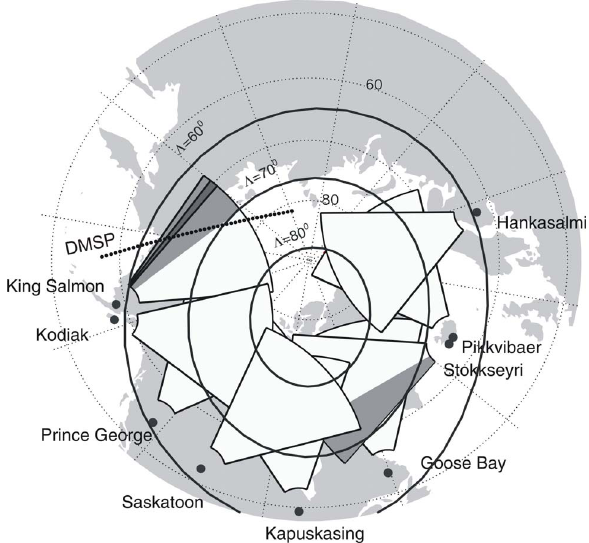
Figure 1. Fields of view (FoV) of the northern hemisphere SuperDARN radars (between 400 and 2800 km), the part of the King Salmon (KS) radar observational area (light shading, beams 0-5) from where the measurements were statistically analyzed in this study and footprints (at a height of 300 km) of DMSP F15 satellite for a pass near the KS FoV. The darker shading within the King Salmon FoV indicates the orientation of beam #1. Light shading within the Stokkseyri radar FoV shows the area (beams 0-5) from where the measurements were statistically analyzed for comparison with the KS data.